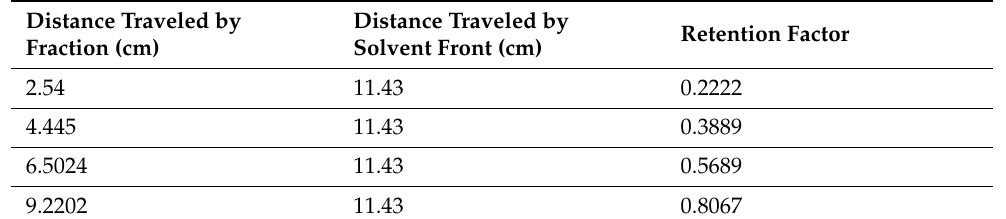
Table 8. Retention factors of S. triloba acetone extract fractionations.